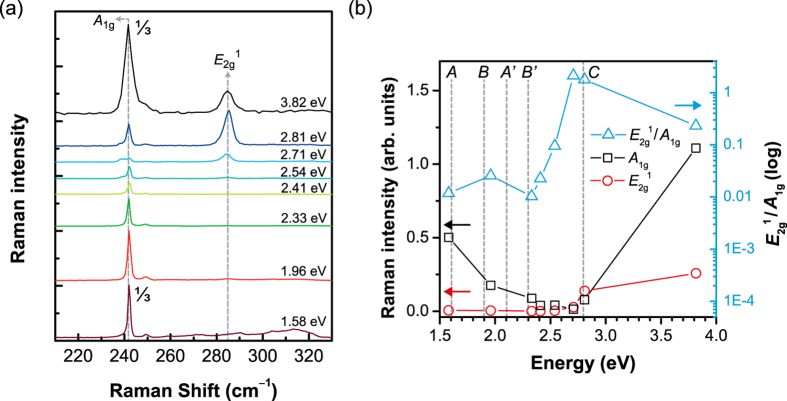
(a) Raman spectra of bulk MoSe2 taken with the excitation energies indicated. (b) Intensities of A1g, and E2g1 modes and E2g1/A1g, ratio as functions of the excitation energy. Some major optical transition energies24 are indicated by capital letters.